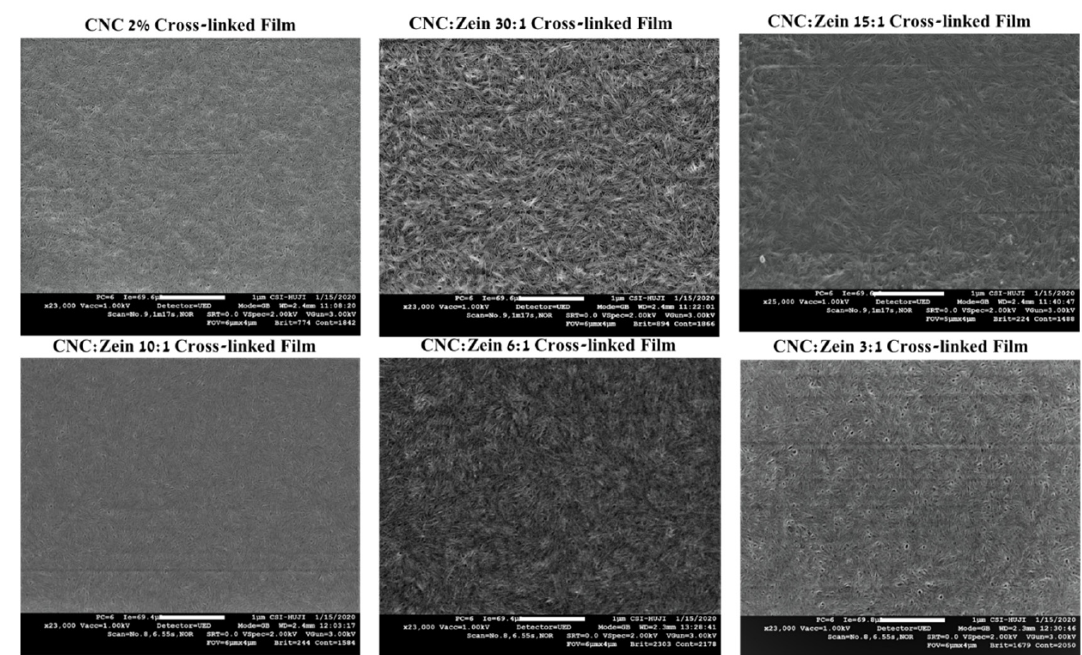
Figure 8. SEM images of non-cross linked CNC and CNC/CZ films. The images are at a magnification of 23,000×.